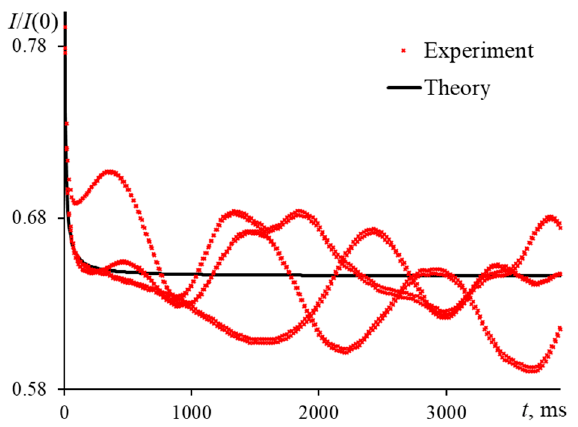
Figure 16. Fluctuations in individual transient curves for a ferroin solution (2.5 µmol/L) attributed to the presence of dust; narrow-focused configuration ( 𝜔 (cid:3032)(cid:2868) = 33 µm, Figure 1, Table 3). As described in [93], the time required to reach the steady state increases with m (for m of ca. 50, 𝑡 > 100 𝑡 (cid:3030) ). In our case (an aqueous solution), 𝑡 (cid:3030),(cid:3047)(cid:3035)(cid:3032)(cid:3042)(cid:3045) = 6.15 ms (Figure 16).